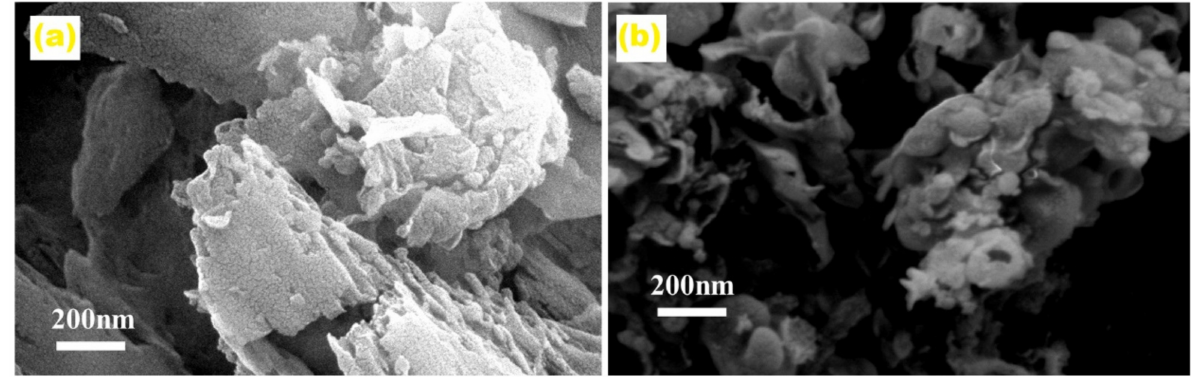
Figure 23. The FESEM image of ( a ) bulk GCN shows a flat surface, and ( b ) Eu-GCN shows a lantern-like hollow surface. Reproduced with permission from Ref.